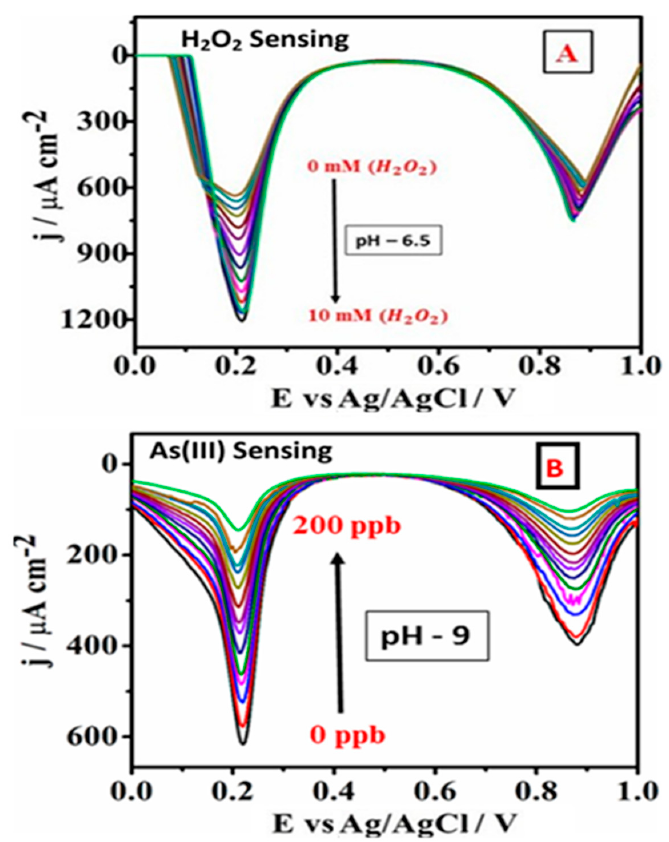
Figure 4. Differential pulse voltammetry of the PB nanoparticle-modified screen-printed electrode in the presence of varying concentrations of hydrogen peroxide. ( A ) (mM): 0.063, 0.126, 0.25, 0.4, 0.8, 1, 2, 3, 4, 5, 8, 10, and As (III). ( B ) (ppb): 20, 40, 60, 80, 100, 120, 140, 160, 180, 200.